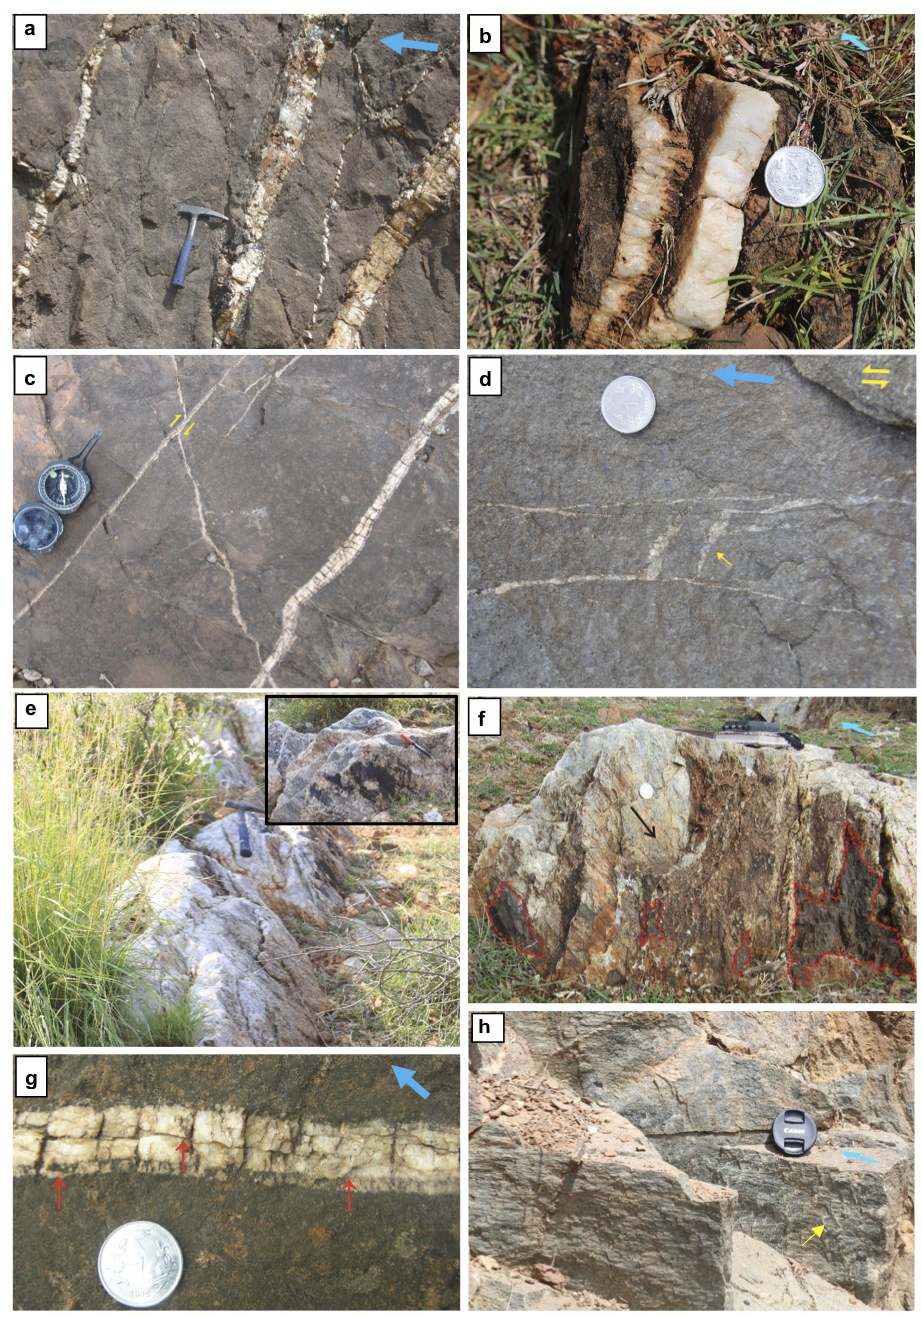
Figure 3. Field photographs from the study area. (a) Crisscross orientation of quartz veins in metabasalt. (b) Close-up of a quartz vein in metabasalt showing crystal growth direction perpendicular to the vein wall. (c) Cross-cutting nature in quartz veins showing dextral displacement (marked by yellow half-arrows). (d) Wing cracks filled up with quartz veins associated with sinistral shearing (marked by yellow arrow). (e) NE-dipping quartz vein showing slickenside lineations (maximum width recorded: 120cm); inset showing a close-up of the fault plane found in (e) . Marker pen placed along the orientation of the slickenside lineations. (f) Angular chunks of metabasalt (enclaves) enclosed within the faulted quartz vein. Dotted red line demarcates the enclave boundaries. Black arrow marks the slickenside lineation on the fault plane. (g) Field photograph of the quartz vein (close view) showing multiple median lines (marked with red arrows) as evidence of the crack-seal mechanism. This clearly indicates cyclic fluid ingression and fault-valve action that led to the formation of veins in the metabasalts of the Chitradurga region. (h) Fault planes in metabasalt showing congruous steps (marked by yellow arrow). Blue arrows in the respective figures point towards